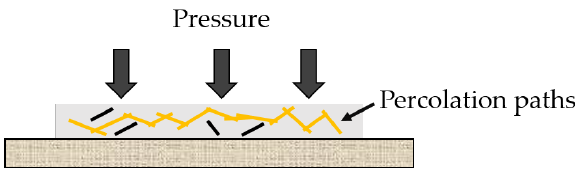
Figure 1. Principle of nanocomposite-based pressure